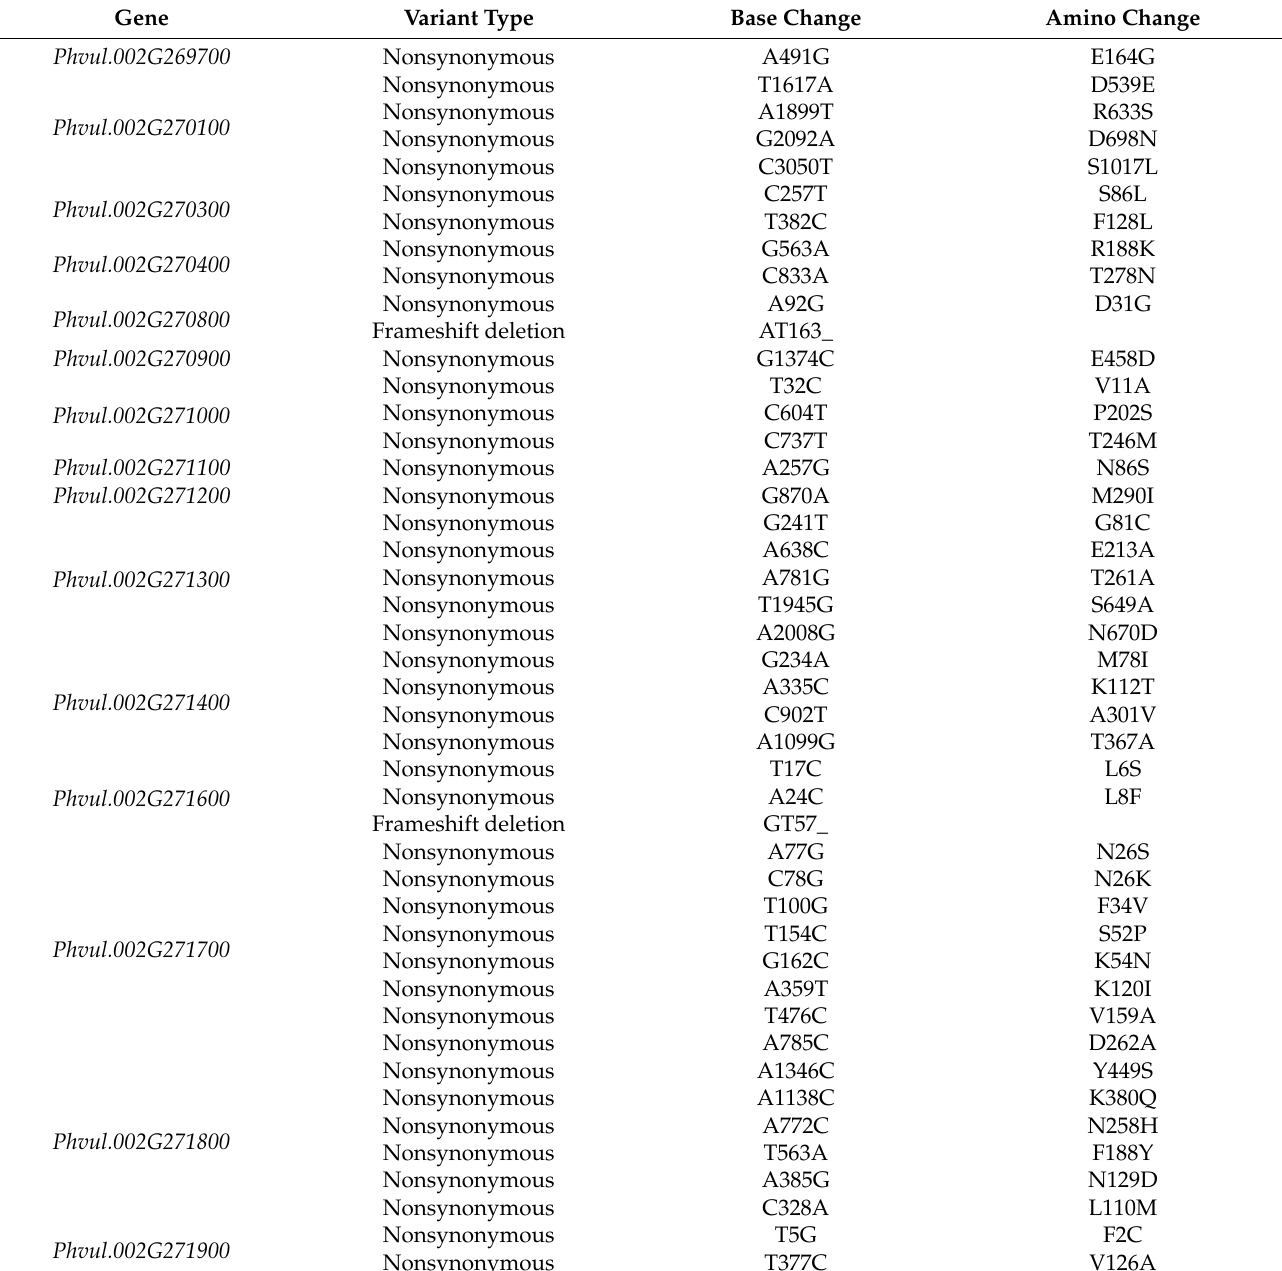
Table 2. Functional annotation information of candidate